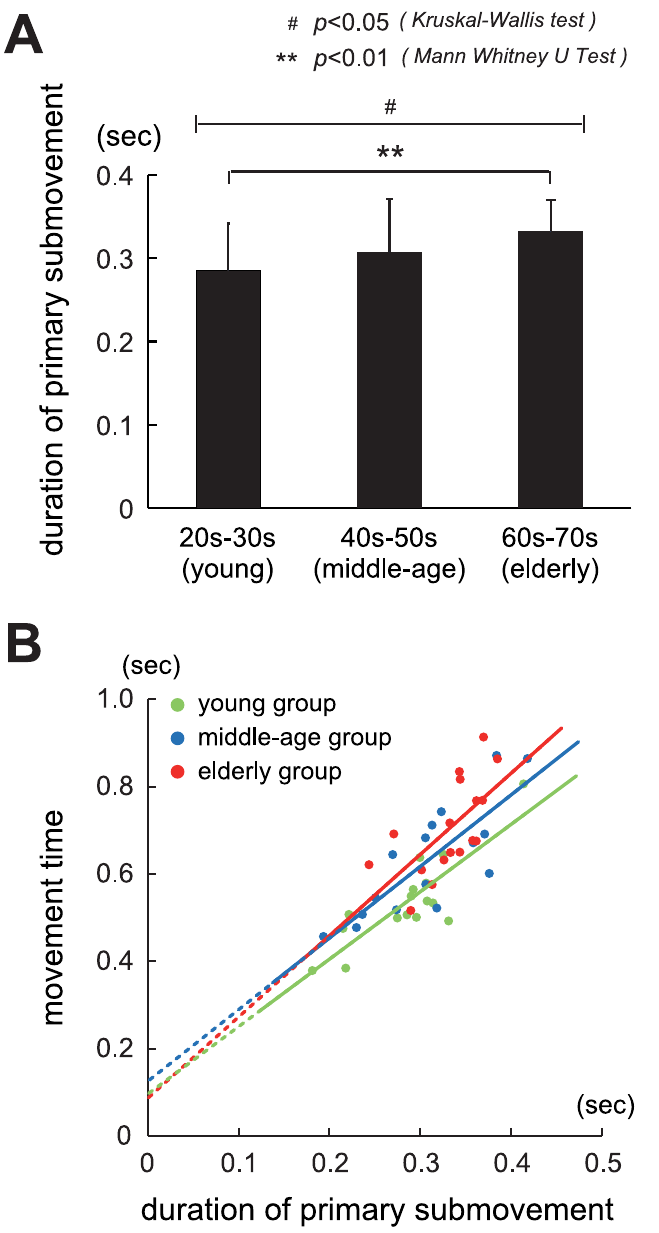
Fig 5. Age-related changes in the duration of primary submovement and its relationship with total movement time. (A) Comparisonof the duration of the primary submovement in the three age groups. Note significantly longerdurationof the submovement for the aged groups(p < 0.029, Kruskal-Wallis test). There was a statistically significantdifference only betweenthe young group (20–30years old) and the elderly group (60–70years old) (p < 0.004, Mann-Whitney U test). (B) Relationship betweenthe durationof the primary submovement and movement time. Green, blue, and red points indicatethe younggroup, the middle-age group and elderly group, respectively.Note that the ratio of the durationof the primary submovement to total movement time tendedto be lower for the aged groups. increasing as the speed of movement became slower. However, the correlation was lower for the higher age groups (R 2 = 0.72 for the young group, 0.66 for the middle-age group, and 0.43 for the elderly group). Also, the ratio of the duration of the primary submovement to the total MT tended to be lower for the aged groups. This result suggests that the proportion of